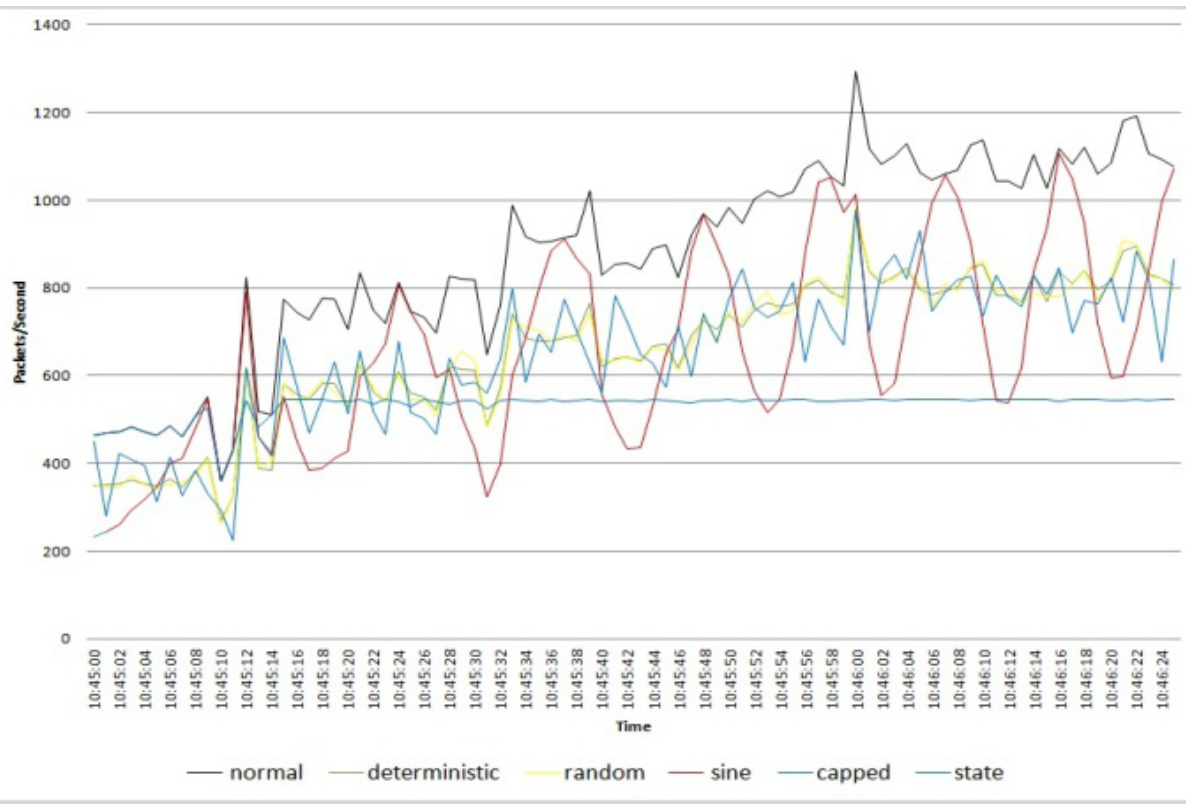
Fig. 4 Effects of 25% Packet Loss on Packets/Second with Various